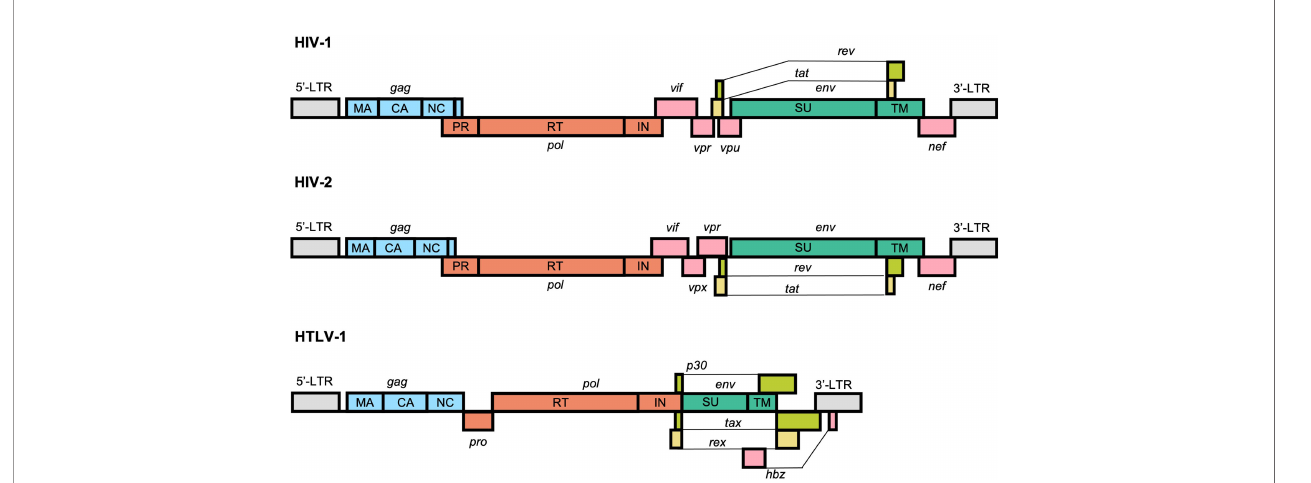
FIGURE 1 | Schematic representation of the typical structure of the HIV-1, HIV-2, and HTLV-1 proviral genomes. All retroviruses encode a core set of genes in a 5 ’ - gag-pol-env -3 ’ structure fl anked by long-terminal repeats (LTRs) that facilitate replication and integration within the genome. HIV-1, HIV-2, and HTLV-1 also encode a unique set of accessory genes, shown in pink, lime green, and yellow, that help facilitate genomic replication and immune evasion and counteract cellular defense mechanisms against the